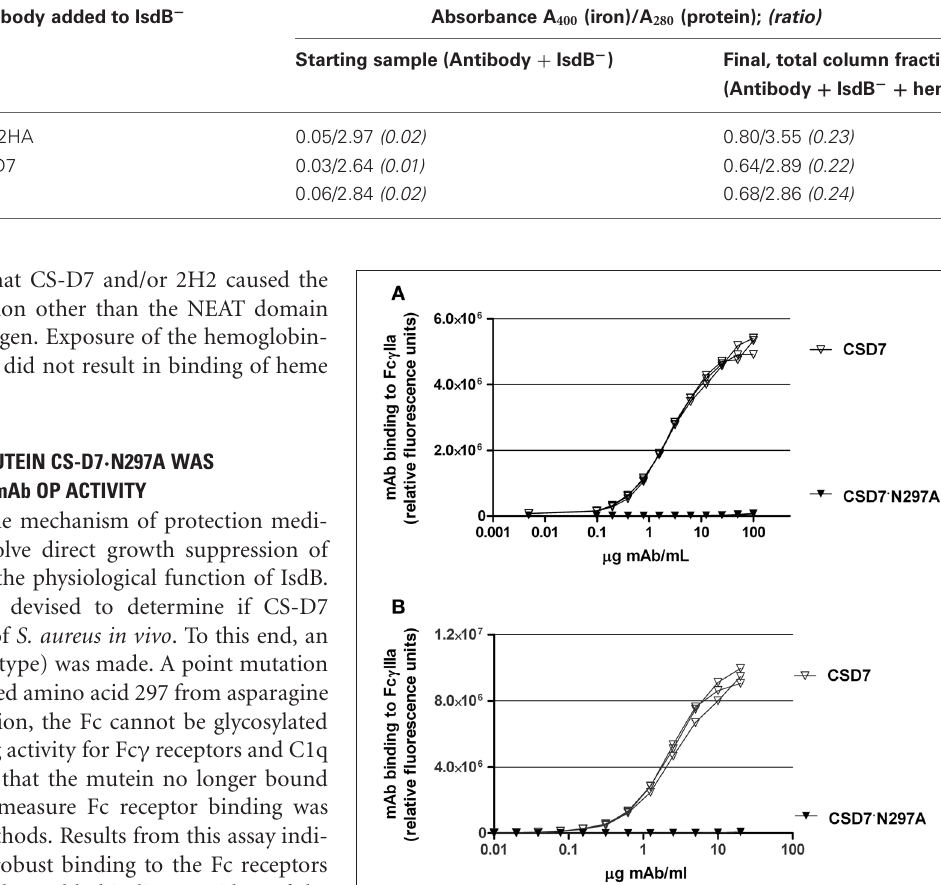
Table 1 | Heme transfer from hemoglobin to heme minus IsdB (IsdB − ) in the presence of mAbs.